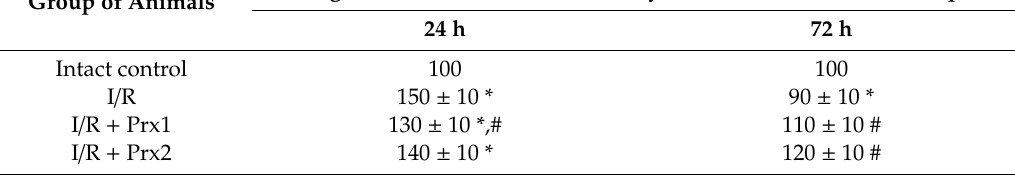
Table 2. Changes in the mass of mouse kidneys following 24 and 72 h after I / R and prior administration of recombinant proteins Prx1 and